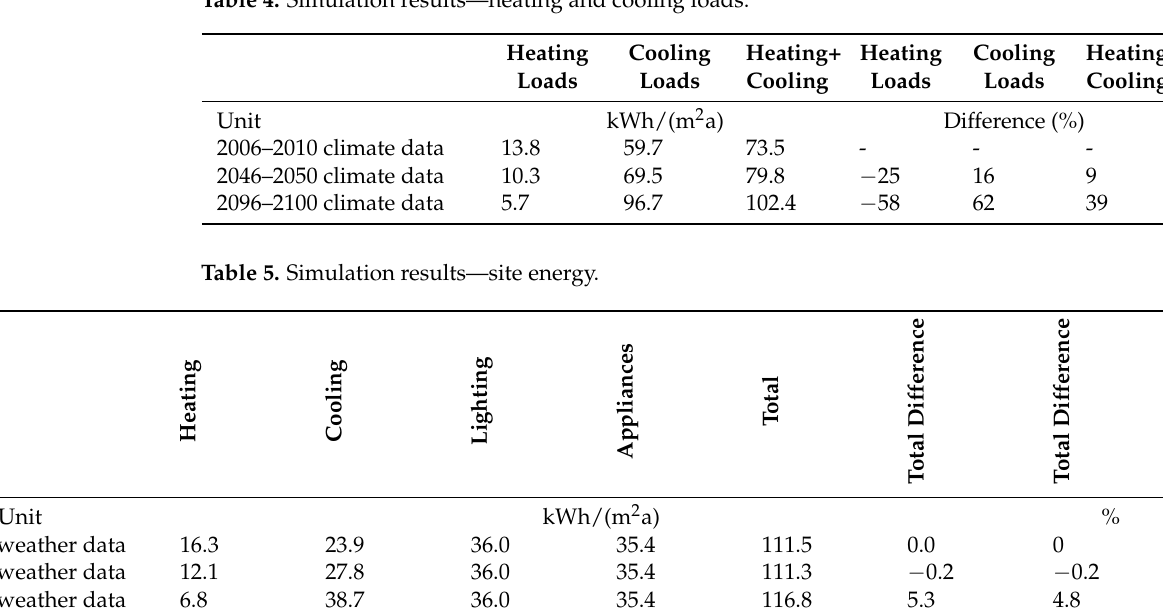
Figure 8. Monthly energy demand for HVAC purposes (comparative).